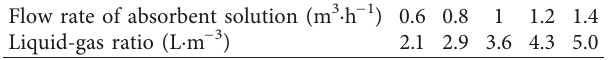
Figure 7: Changes of NO x concentrations at inlet and outlet ports of the RPB reactor (a) and NO x removal efficiencies (b) with liquid-gas ratios. Table 3: The data of flow rates of absorbent solution and liquid-gas